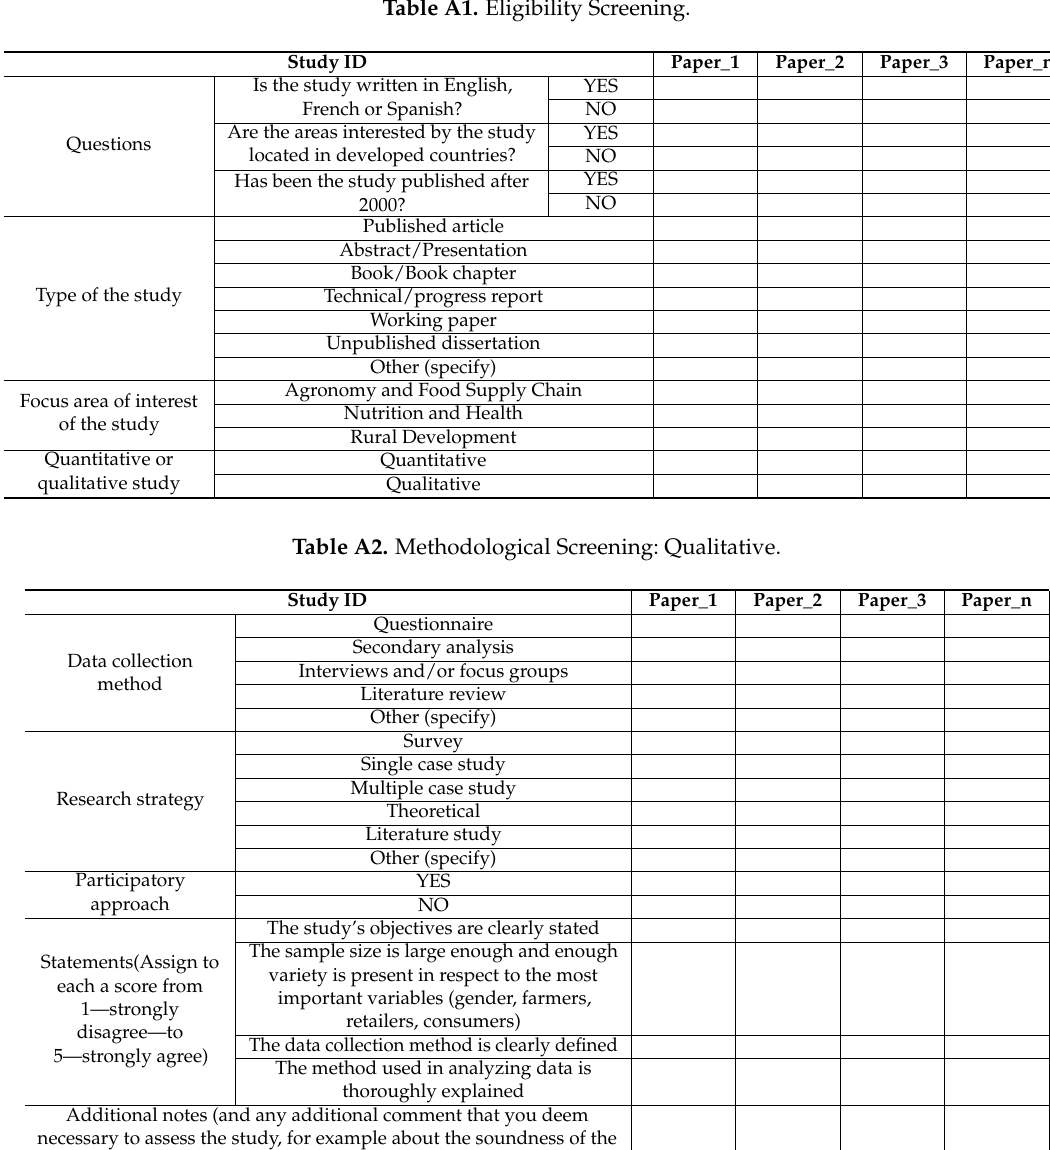
Table A1. Eligibility Screening.